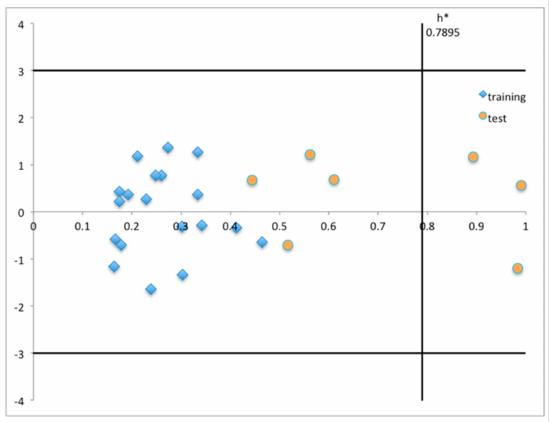
Figure 2. Williams plot for the built model representing the leverage values for the training and test set